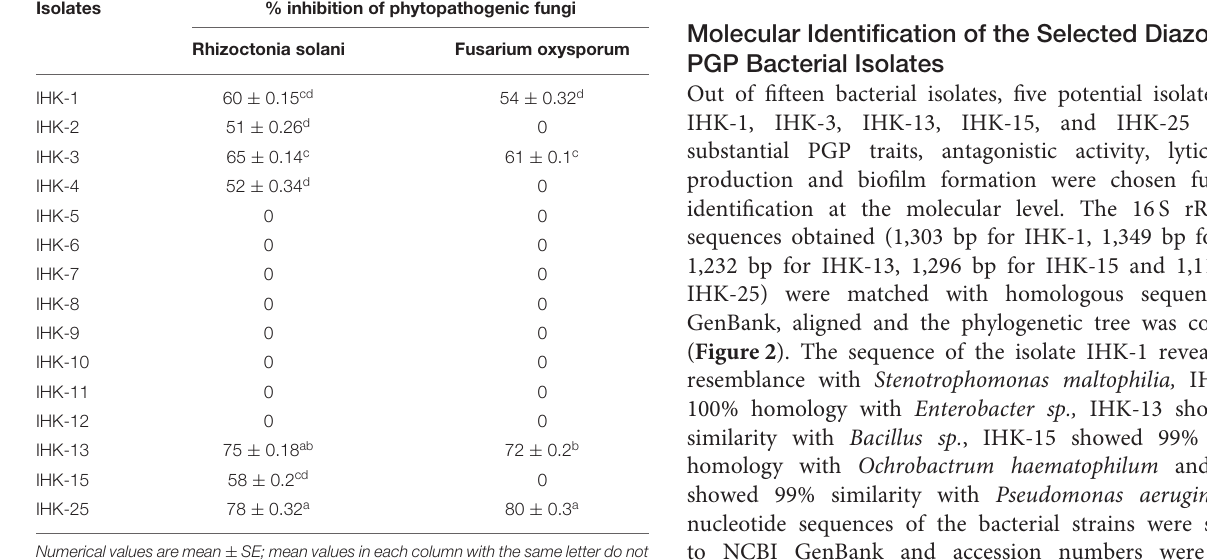
TABLE 4 | Antagonistic activity against soil-borne phytopathogenic fungi.